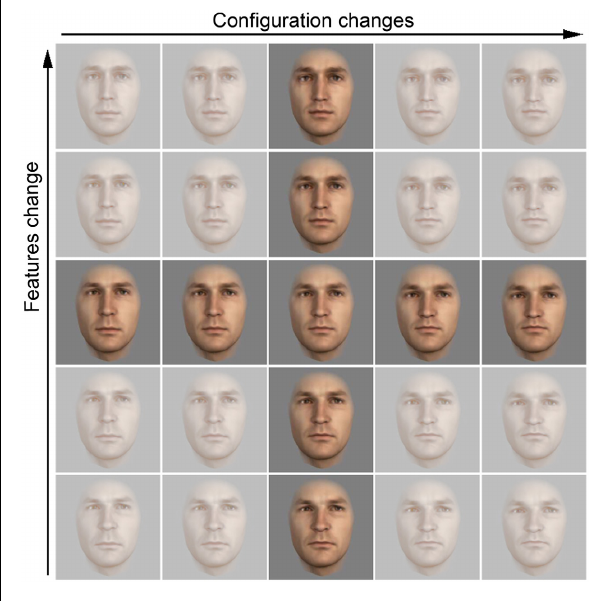
FIGURE 4 | One of the eight sets of face stimuli used in the similarity rating experiment. Only faces of the central horizontal and vertical bars were used for the experiments. The endpoint faces were used to calculate mean pixelwise image differences between the stimuli.